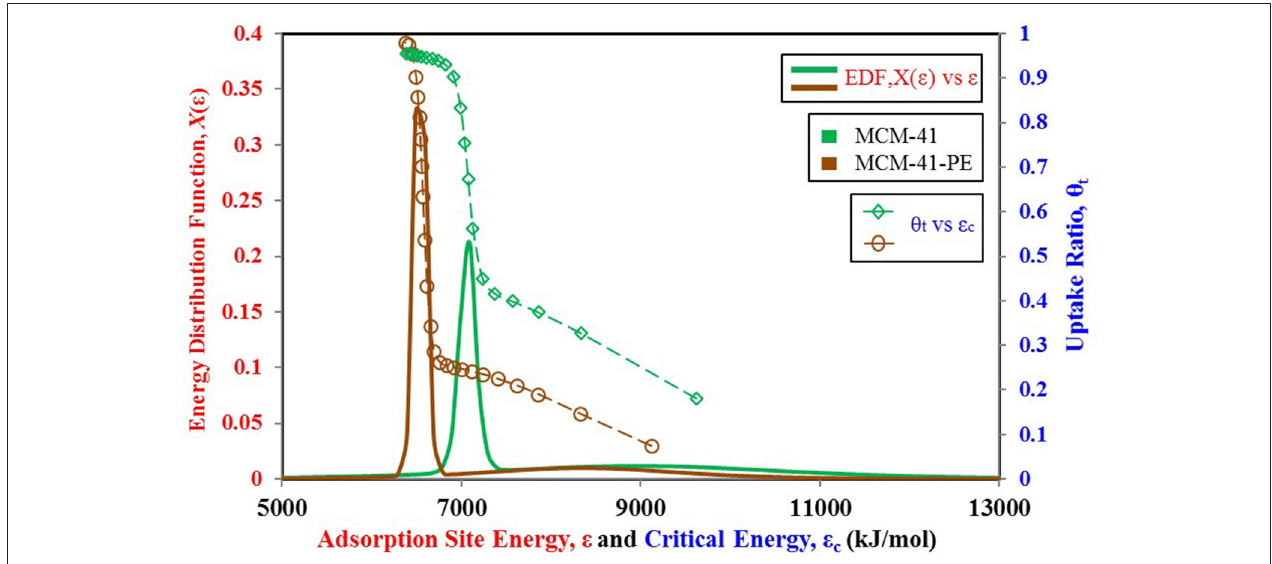
FIGURE 10 | Adsorption sites energy distribution for MCM-41 and MCM-41-PE paired with nitrogen as